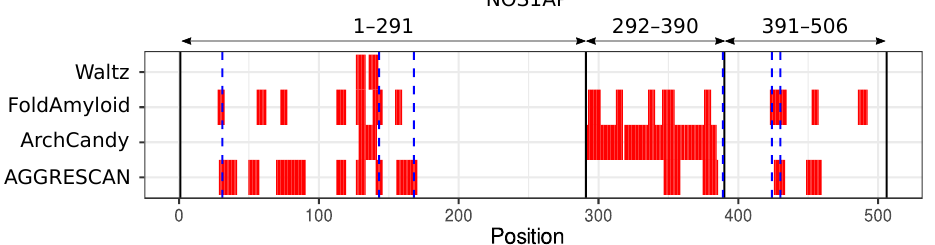
Figure 1. Aggregation-prone regions in NOS1AP. Red rectangles correspond to the potentially amyloidogenic regions. Vertical black lines mark the three regions analyzed in this work. Blue dashed lines designate the positions of